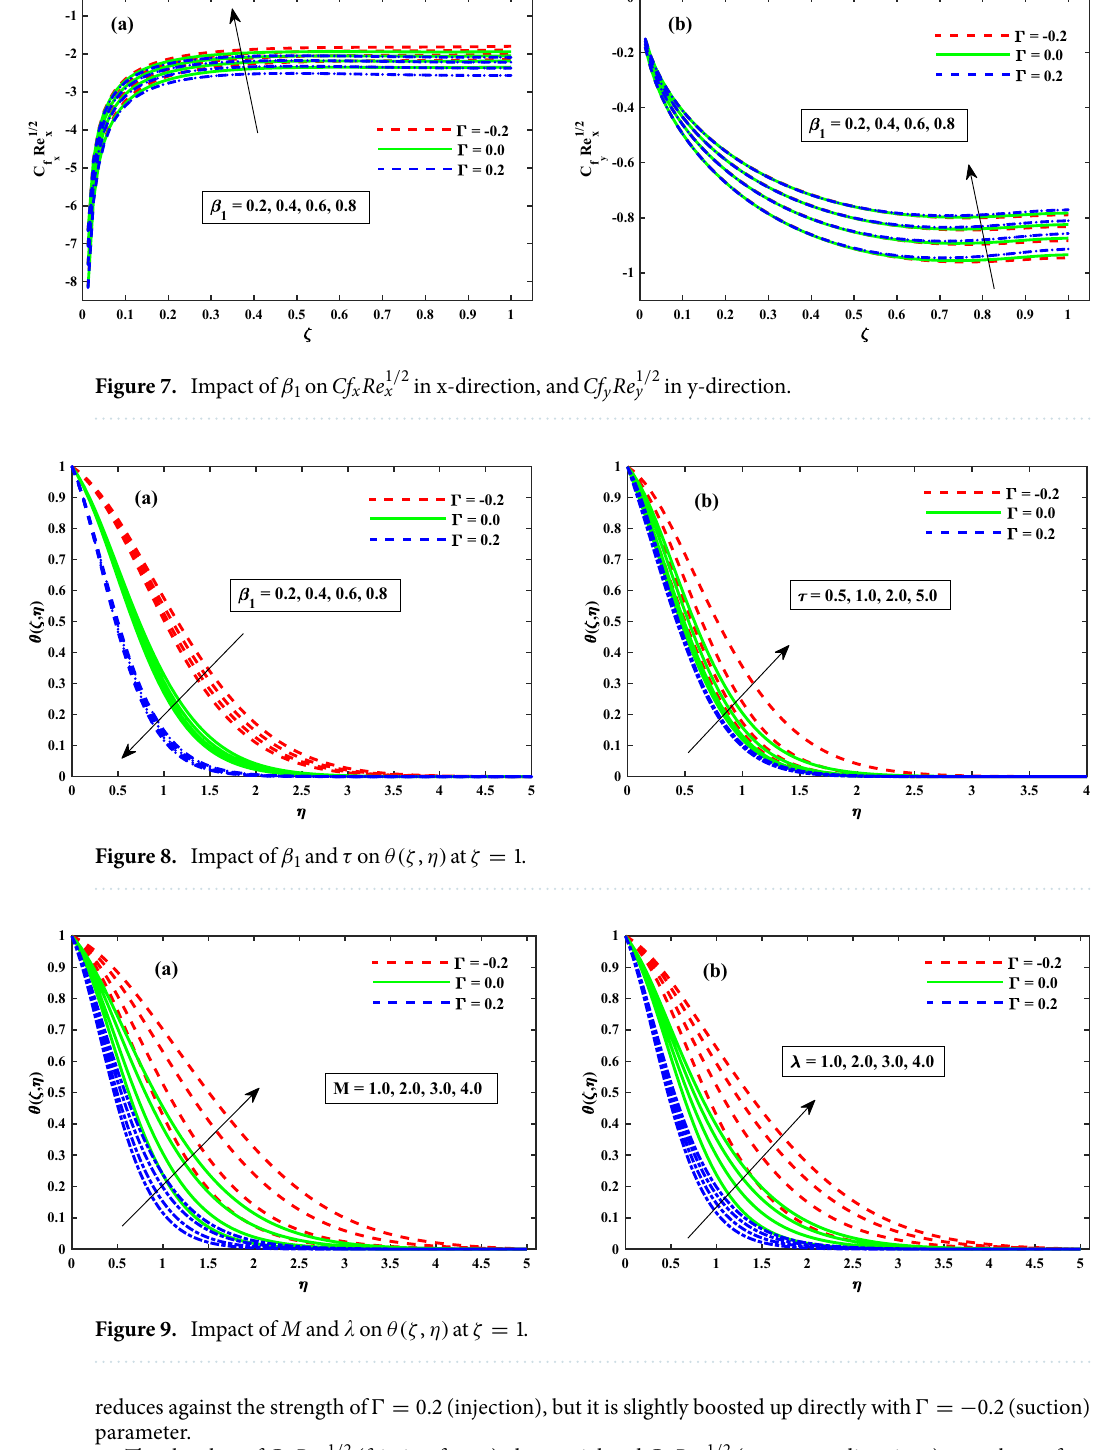
Figure 9. Impact of M and (cid:31) on θ(ζ , η) at ζ